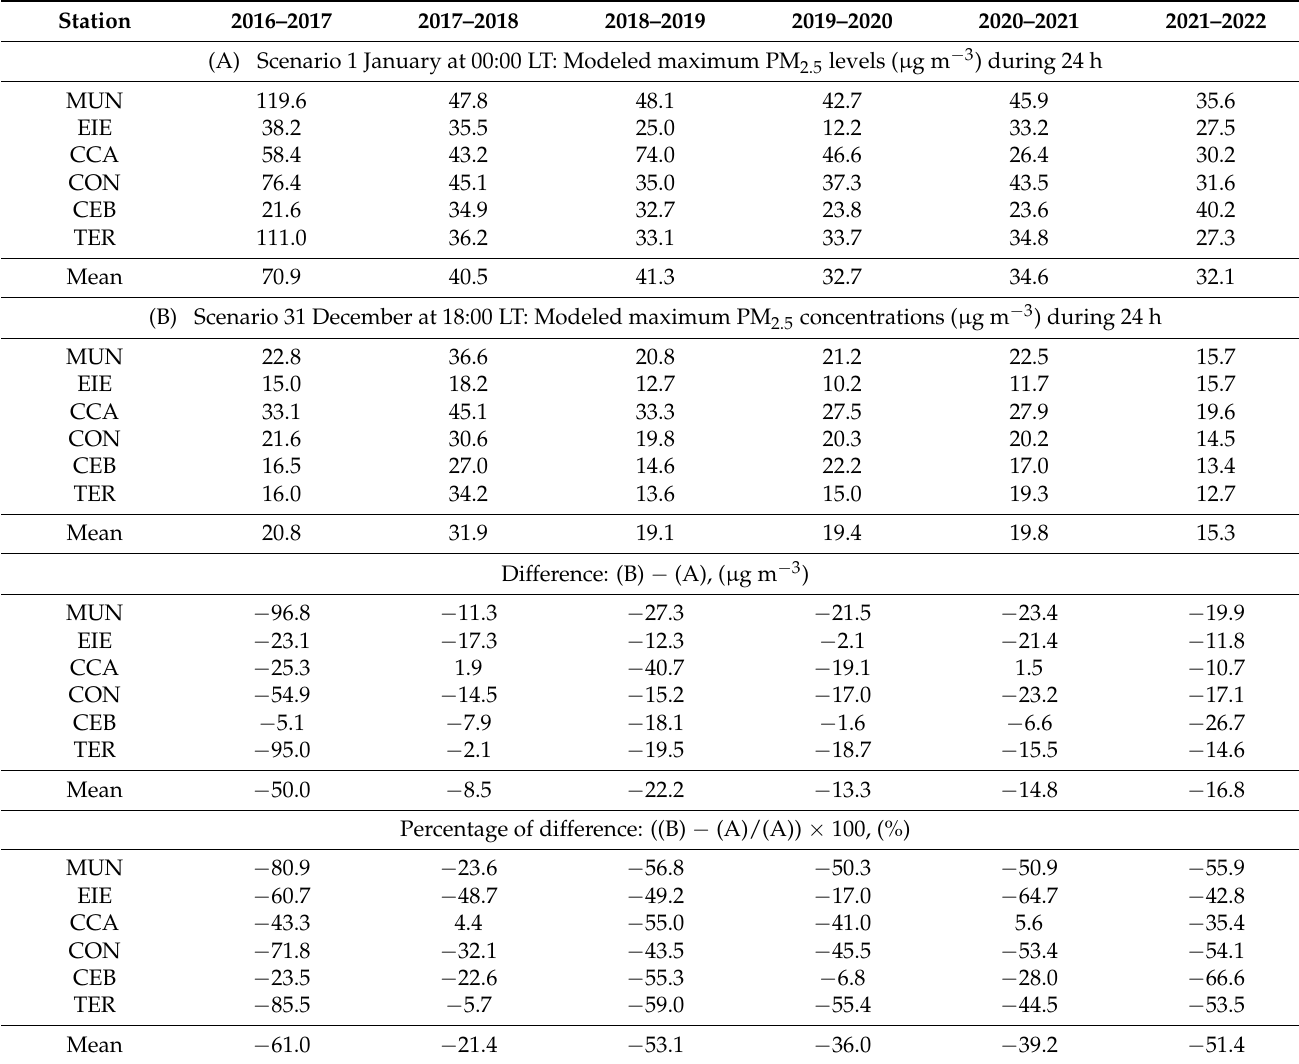
Table 4. Effect of advancing the time of burning puppets and fireworks. Scenario 1 January at 00:00 LT vs. 31 December at 18:00